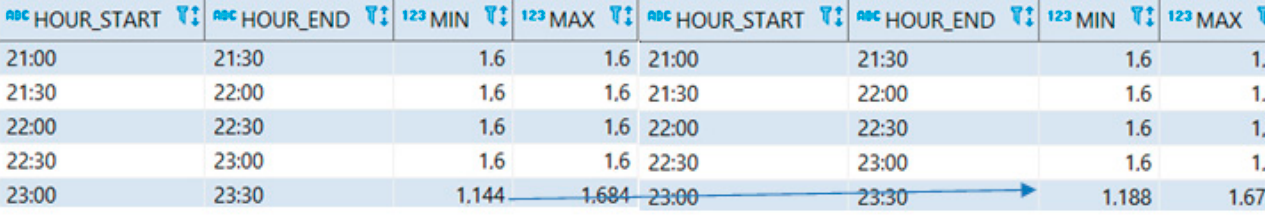
Figure 9. Changes in user-behavior profile on consecutive days.